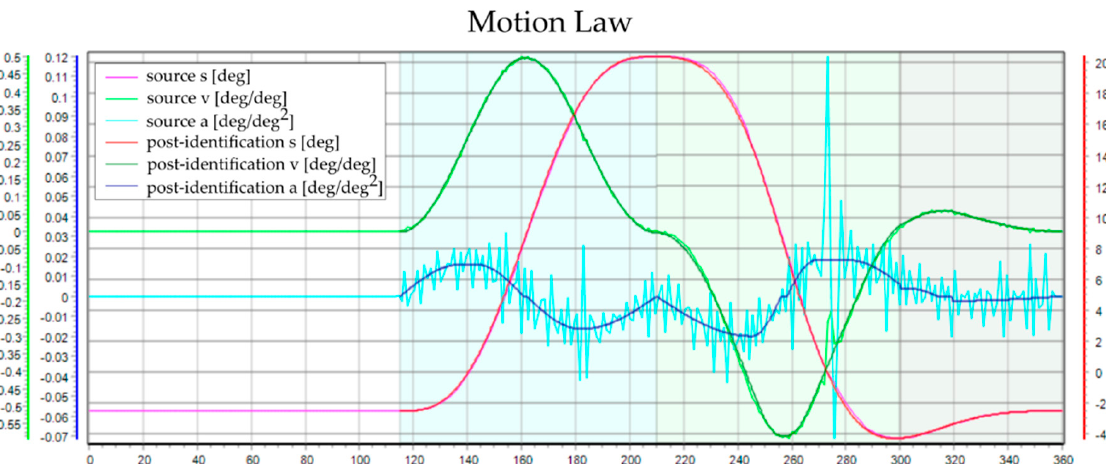
Figure 14. Comparison between the experimental law of motion (light blue) and modified trapezoidal laws for each phase (with equal coefficients values) after identification based on velocity by adopting the DTW algorithm.